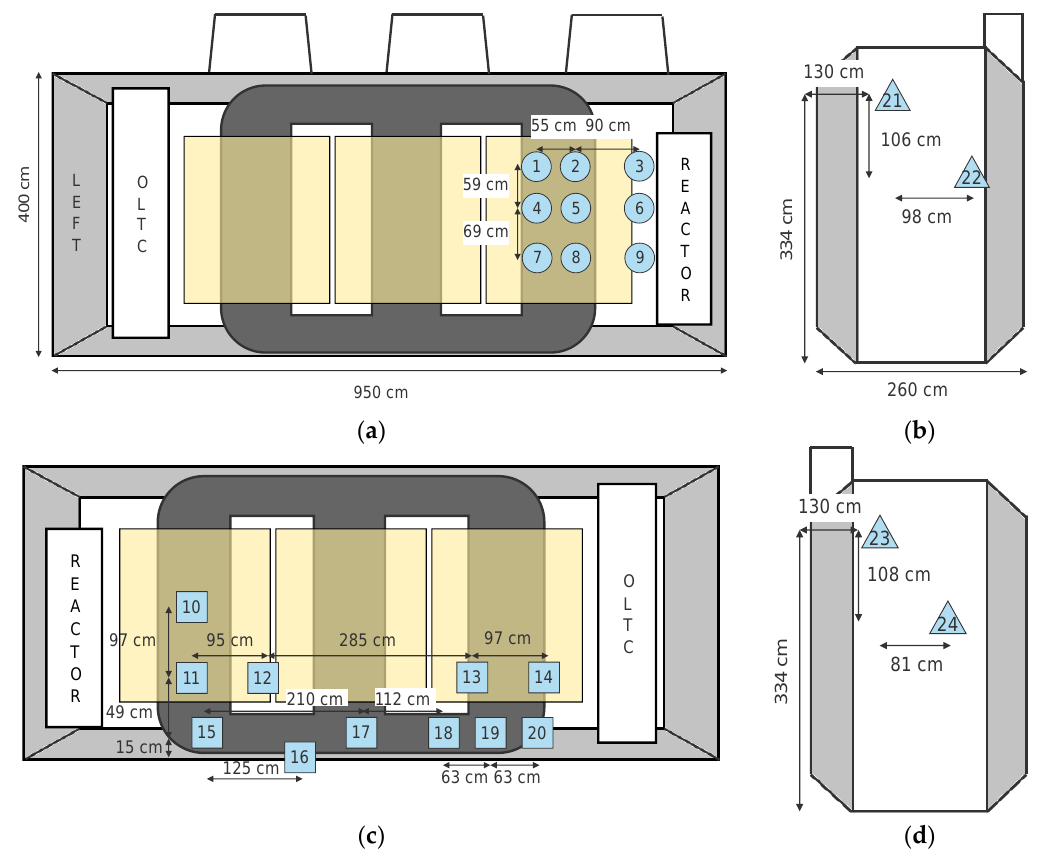
Figure 1. Positions of sensors on the different tank walls of transformer A: ( a ) front view; ( b ) left side view; ( c ) rear view; ( d ) right side view.